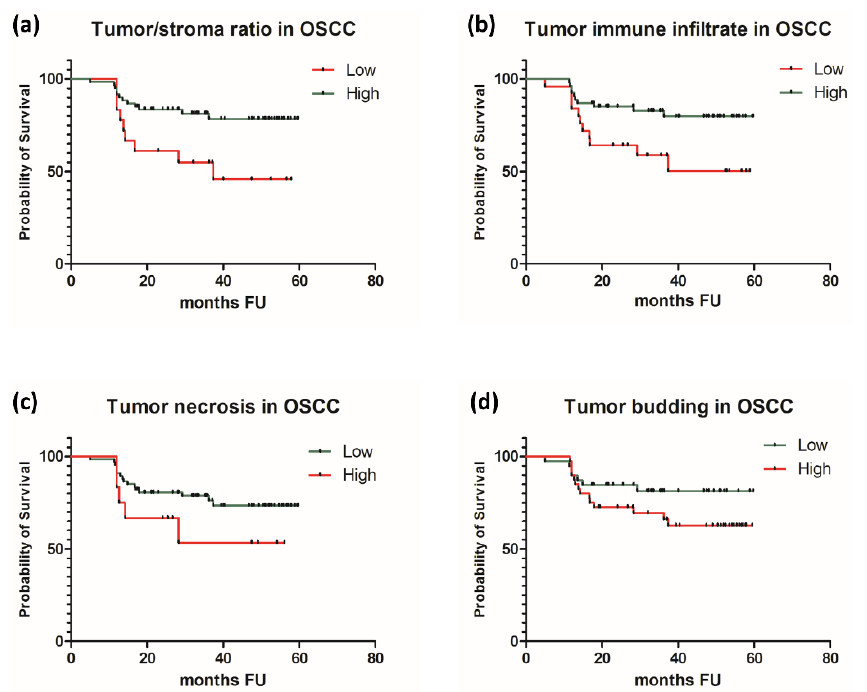
Figure 2. Survival curves in OSCC for ( a ) tumor/stroma ratio, ( b ) immune infiltration at the front of invasion, ( c ) tumor necrosis, and ( d ) tumor budding.